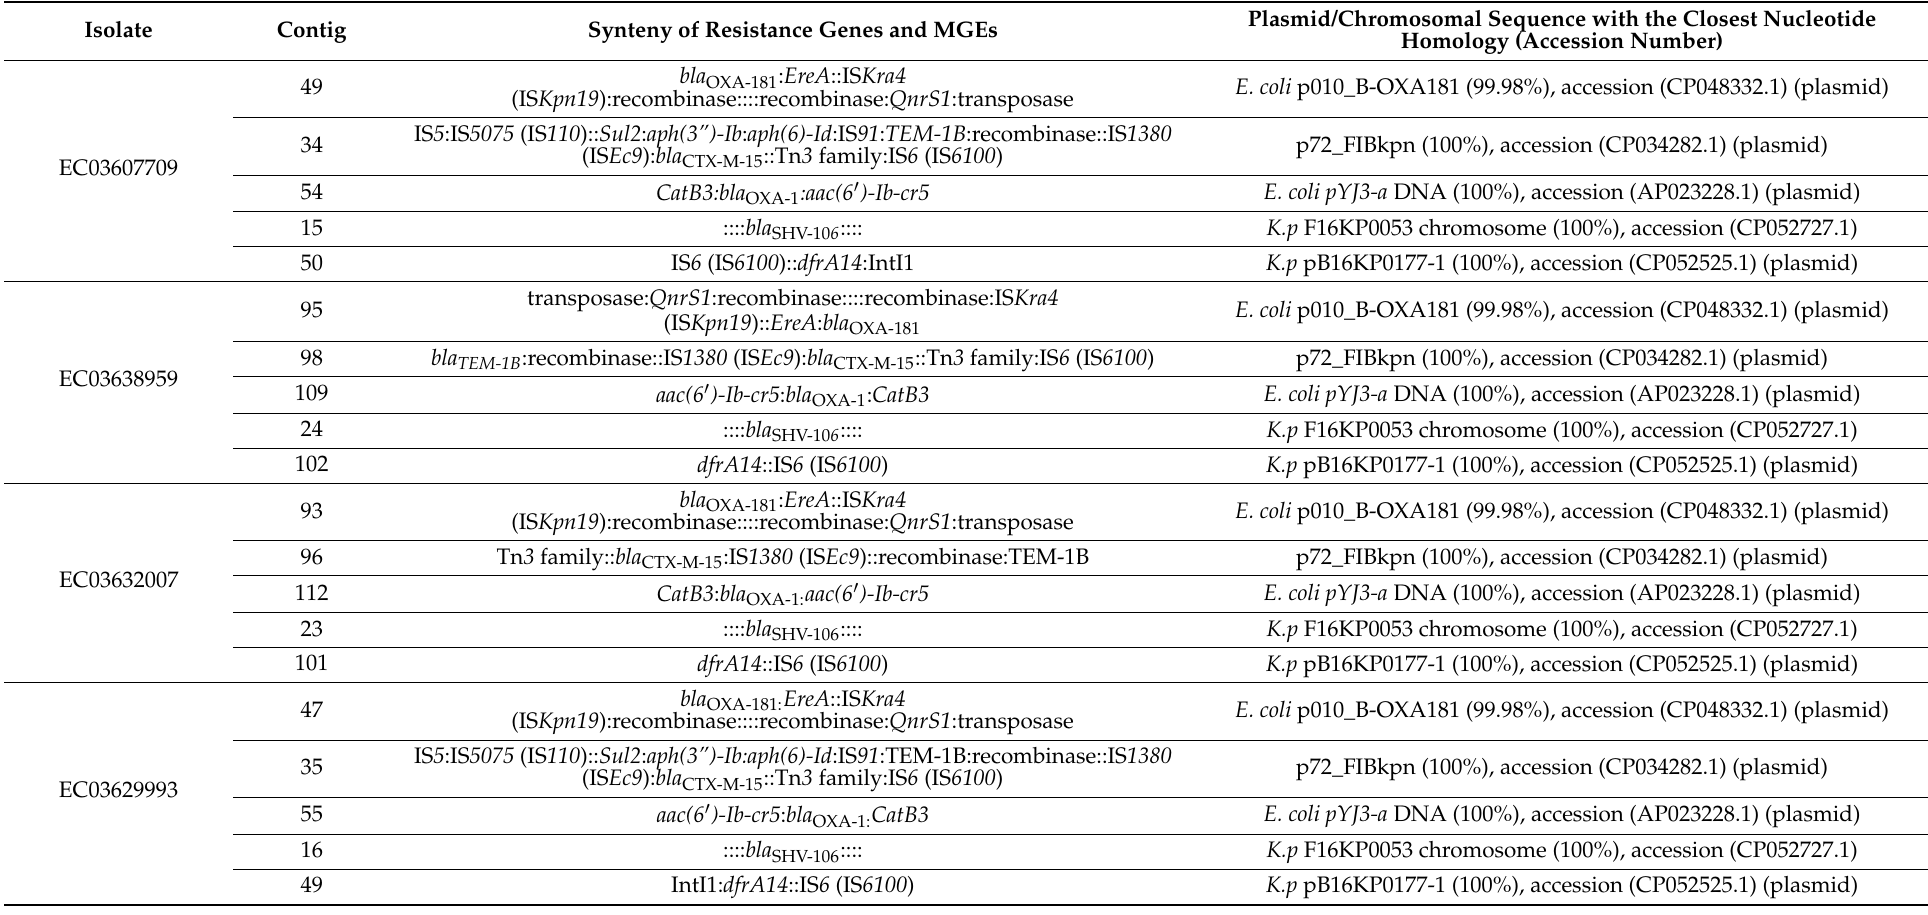
Table 3. ARGs and MGEs in synteny and their plasmidic/chromosomal locations. Isolate Contig Synteny of Resistance Genes and MGEs